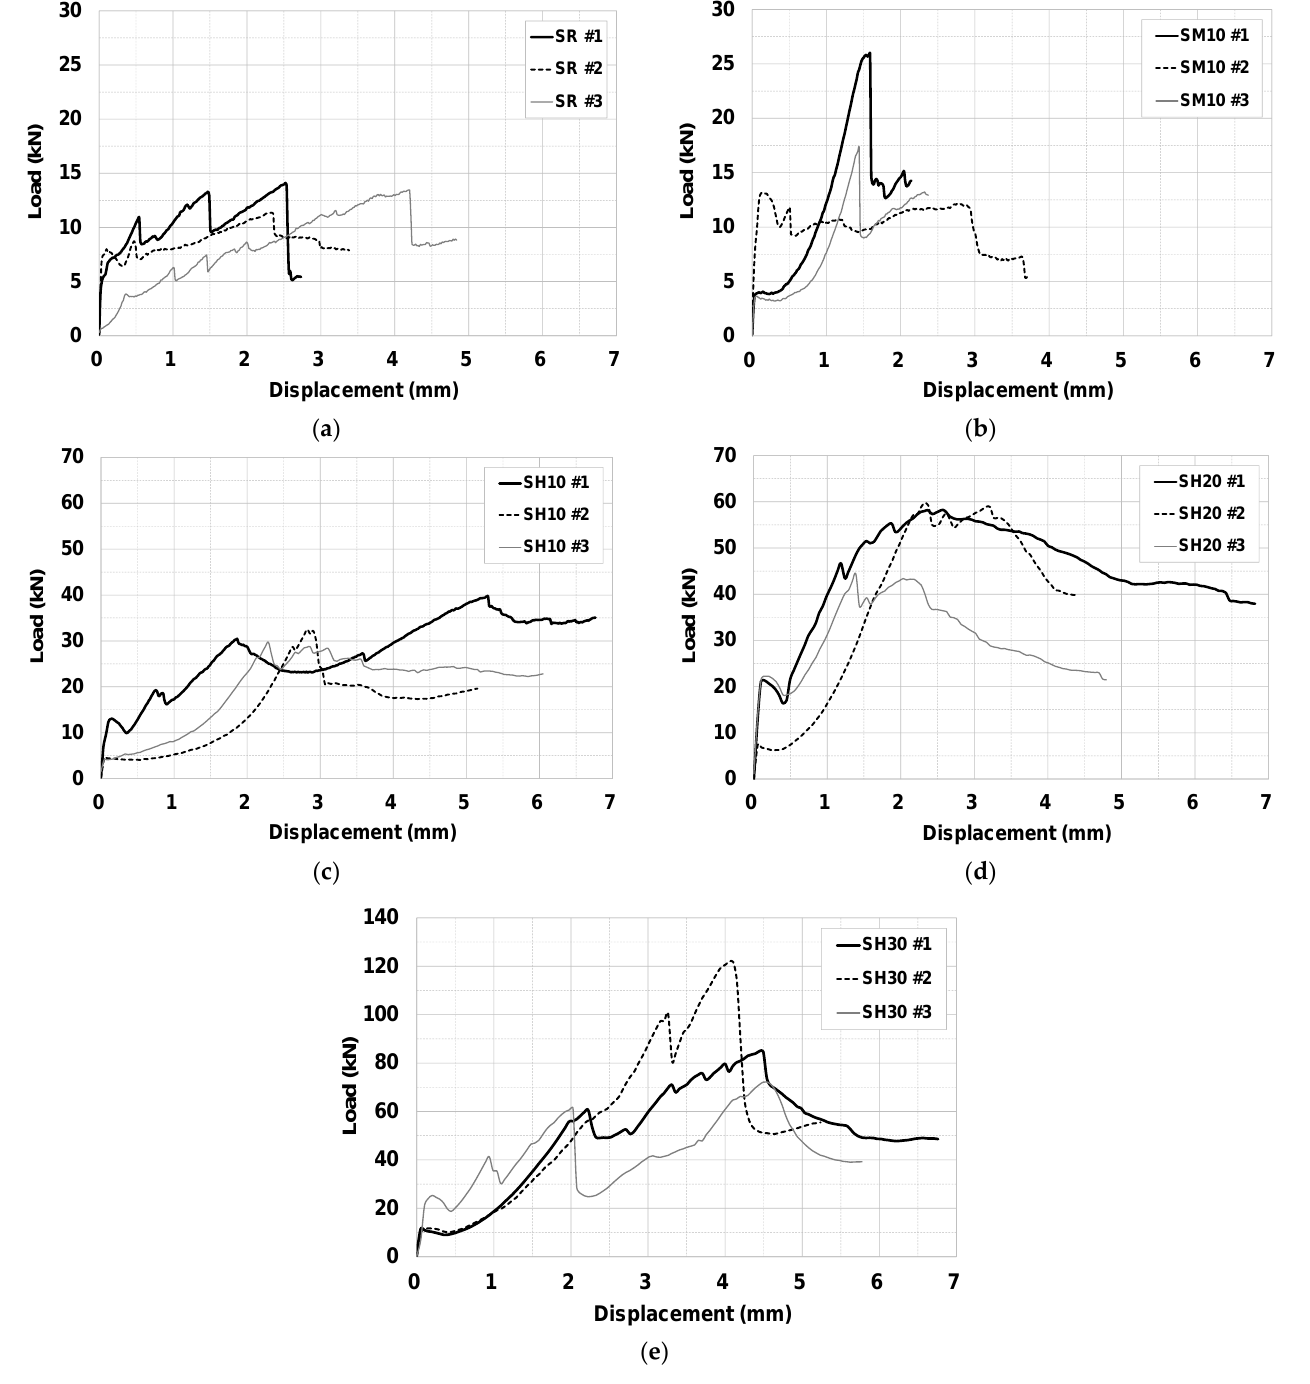
Figure 8. Load – displacement response of initial shear strength test: ( a ) SR; ( b ) SM10; ( c ) SH10; ( d ) SH20; ( e ) SH30.